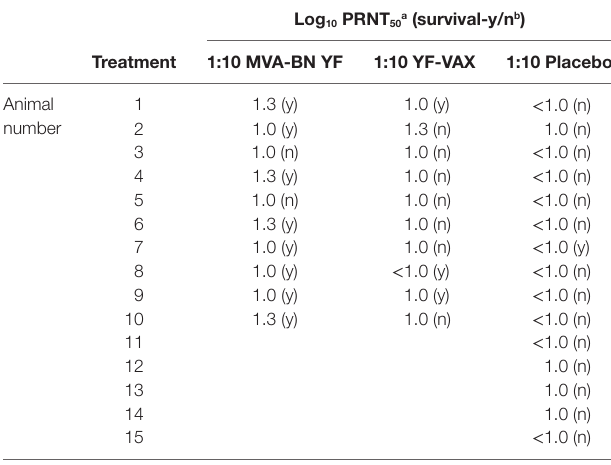
TaBle 3 | Neutralizing antibody titers present in serum 24 h after treatment with a 1:10 dilution of immune serum.